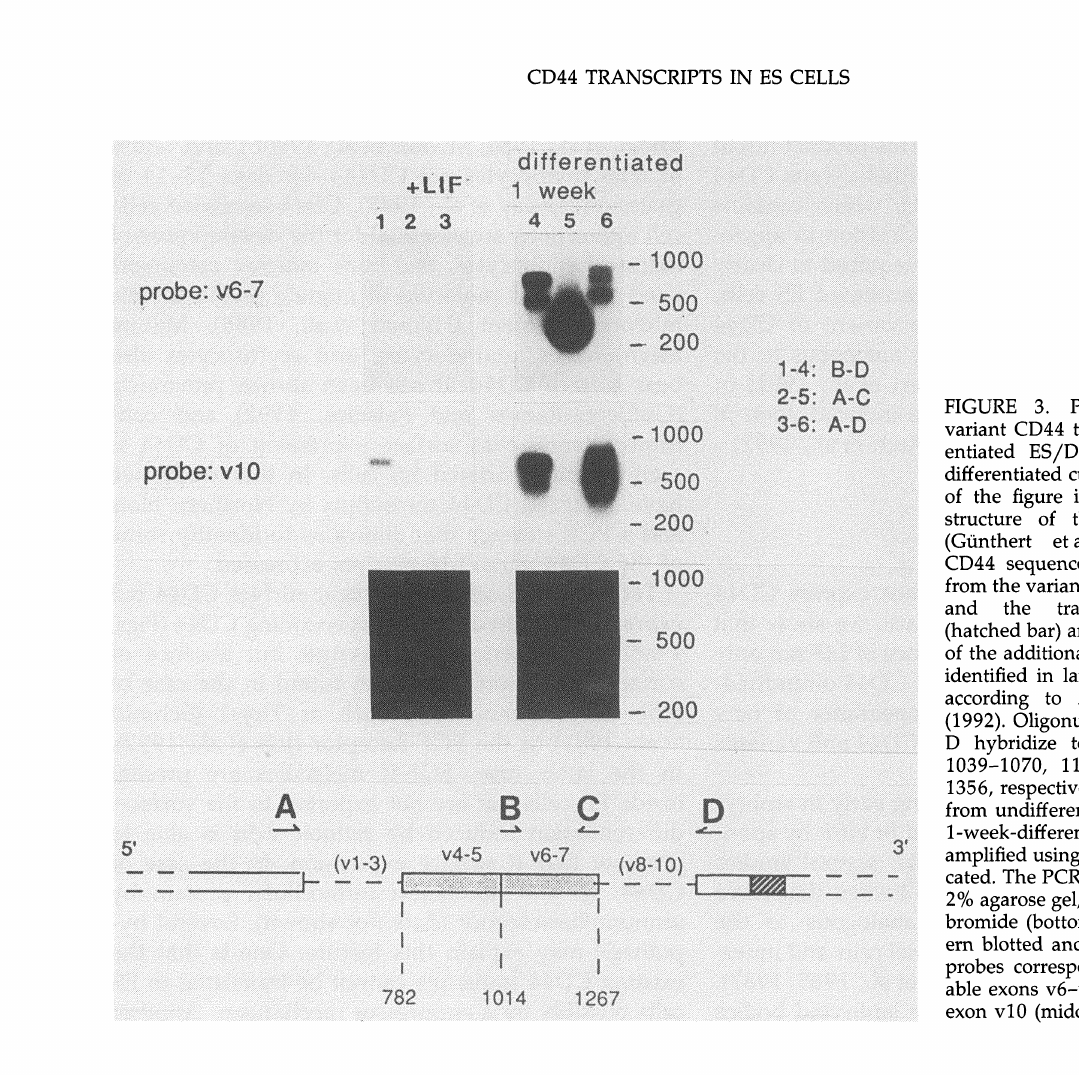
FIGURE 3. PCR amplification of variant CD44 transcripts in undiffer- entiated ES/D3 cells and 1-week- differentiated cultures. At the bottom of the figure is shown a schematic structure of the p-meta-1 variant (Ginthert et al., 1991). Standard CD44 sequences (open bars), exons from the variant region (shaded bars), and the transmembrane region (hatched bar) are shown. Localization of the additional exons (dashed lines) identified in larger CD44 variants is according to Arch and colleagues (1992). Oligonucleotides A, B, C, and D hybridize to positions 653-680, 1039-1070, 1146-1173, and 1328- 1356, respectively. At the top, cDNA from undifferentiated ES/D3 cells or 1-week-differentiated cultures were amplified using the primer pairs indi- cated. The PCR products separated in 2% agarose gel, stained with ethidum bromide (bottom panel) were South- ern blotted and hybridized to cDNA probes corresponding either to vari- able exons v6-v7 (upper panel) or to exon vl0 (middle